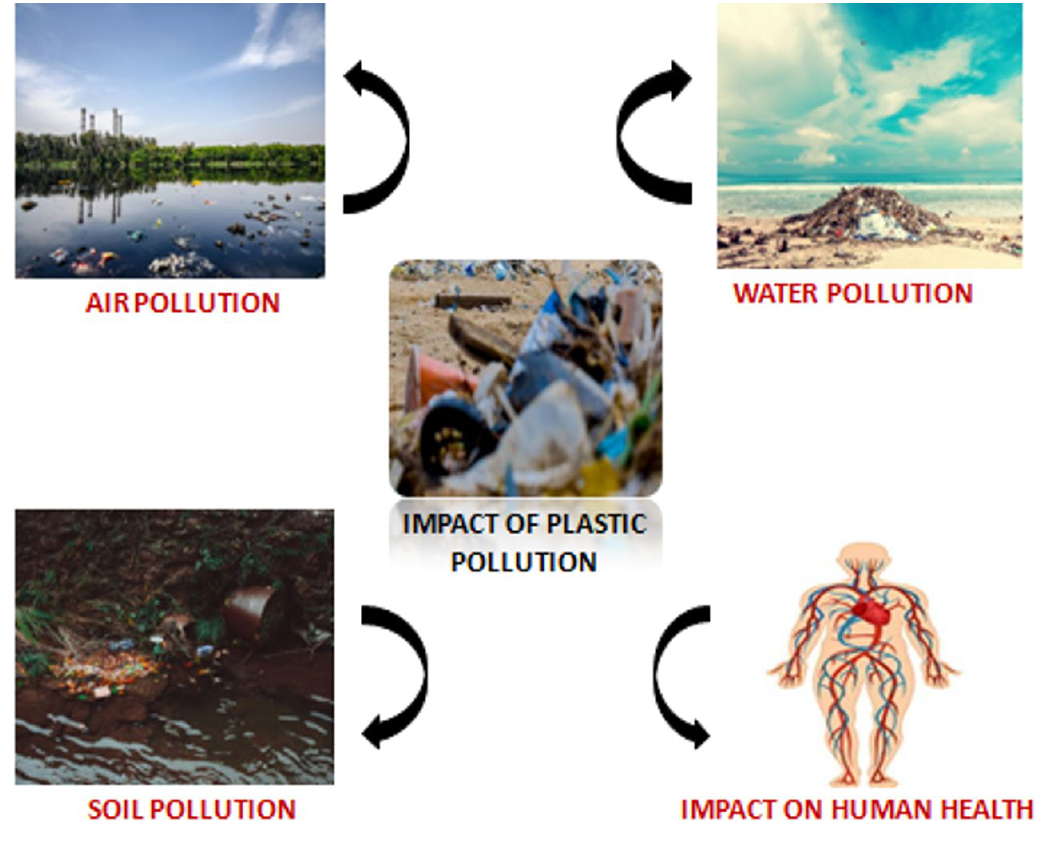
Fig. 3. Impact of plastic pollution on the